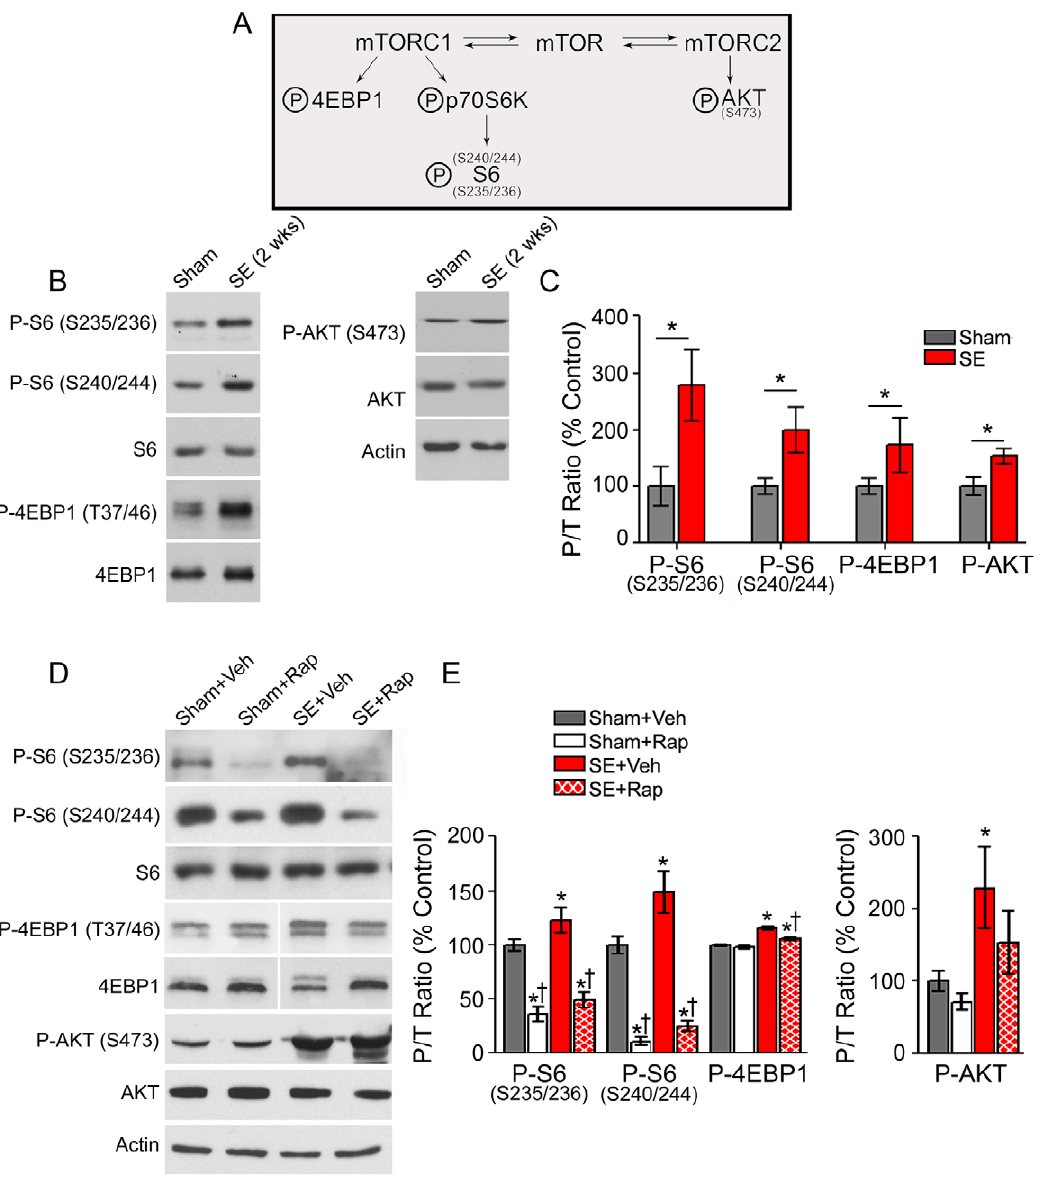
Figure 4. Rapamycin treatment suppressed SE-induced hyperphosphorylation of mTORC1 downstream targets. Western blotting was performed in whole hippocampal homogenates from SE and sham rats 2 weeks after SE ( B – C ) and after treatment with rapamycin (Rap) or vehicle (Veh) following the behavioral tests ( D – E ). ( A ) Diagram illustrating mTORC1/2 targets evaluated. ( B ) Representative immunoblots from hippocampal proteins derived from sham and SE rats 2 weeks after pilocarpine-induced SE probed for the total and phosphorylated (P-) forms of S6, 4EBP1, AKT and actin are shown. ( C ) Quantitative analysis of the phosphorylated to total protein (P/T) ratio shows a significant increase in P-S6, P-4EBP1 and P- AKT 2 weeks after SE compared to shams. * P , 0.05, student’s t test; n=3 2 5. ( D ) Representative immunoblots from hippocampal proteins derived from Sham + Veh, Sham + Rap, SE + Veh and SE + Rap following behavioral tests, probed for total and P- S6, 4EBP1, AKT, and actin are shown. ( E ) Quantitative analysis of the P/T ratio of immunoreactive bands shows significantly increased levels of P-S6, P-4EBP1, and P-AKT in the SE + Veh group compared to Sham + Veh. Rapamycin suppressed P-S6 levels in the Sham + Rap and SE + Rap groups, and partially reduced P-4EBP1 in the SE + Rap group but not in the Sham + Rap group. P-AKT levels remained elevated despite rapamycin treatment. Note that blots for total and phospho-4EBP1 were run in the same gel but were noncontiguous. * compared to Sham + Veh, P , 0.05; { compared to SE + Veh, P , 0.05, ANOVA with Tukey’s post hoc test; n=5 2 8. Error bars=SEM. group. Due to the low levels of P-S6 staining in the rapamycin- treated groups, we did not find co-localization with the IBA1 or GFAP markers following rapamycin treatments (data not shown). We did not find P-S6 co-localization with oligodendrocytes, Map2, synaptophysin, Gad67, or Neurofilament M in any of the groups (data not shown).